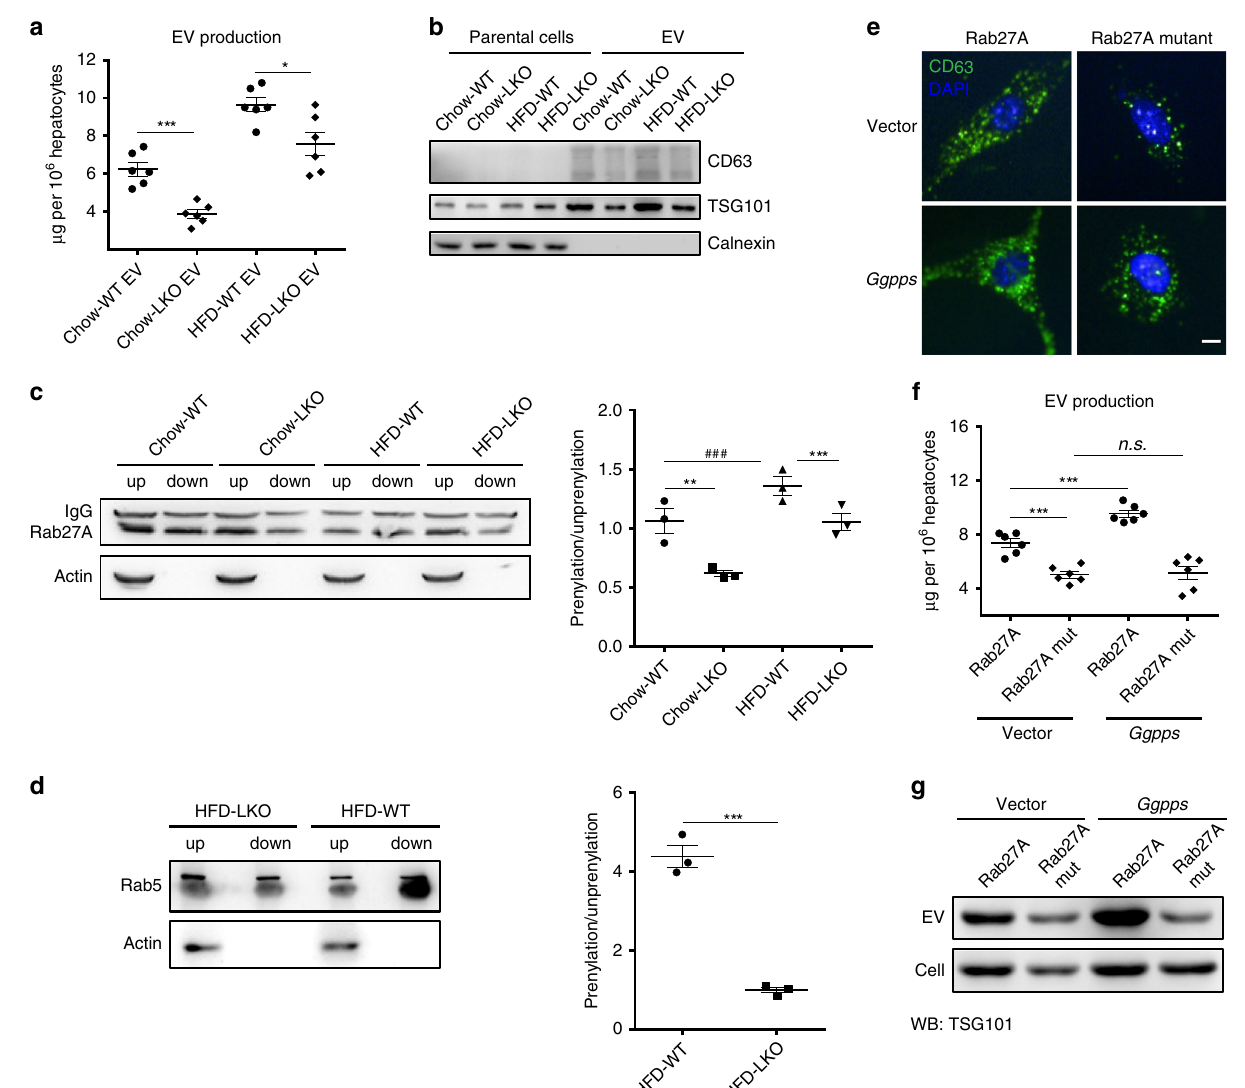
Fig. 4 Ggpps regulates hepatocyte-derived EV secretion. a EV production by primary hepatocytes from WT and liver-speci fi c Ggpps knockout mice (LKO) fed a normal chow diet or a HFD. ( n = 6 mice per group). b CD63, TSG101 and Calnexin protein levels in parental cells and EVs from WT and LKO mice